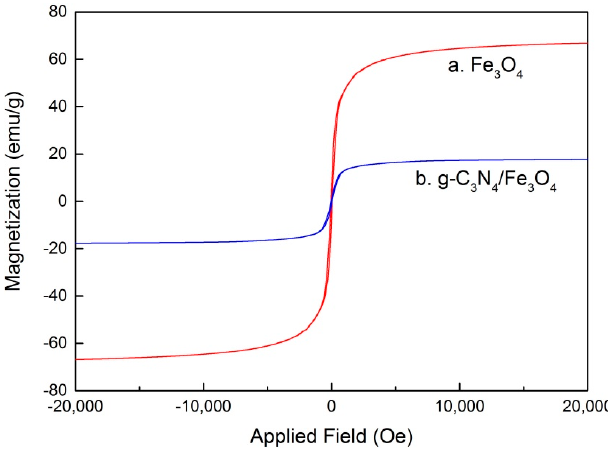
Figure 6. Magnetization curves of Fe 3 O 4 ( a ) and g-C 3 N 4 / Fe 3 O 4 ( b ).